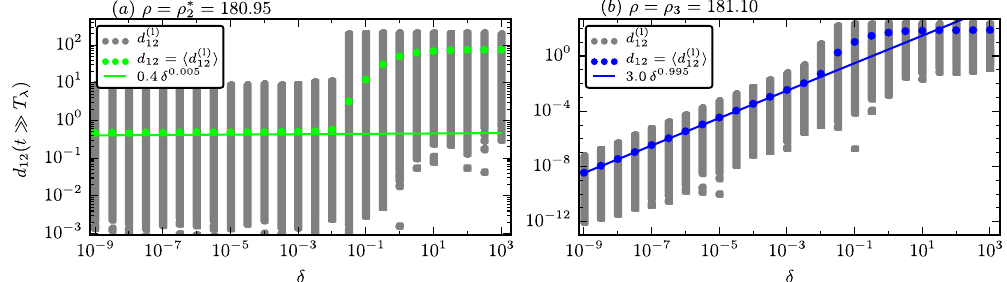
Figure 5. The scaling behavior of the averaged long-term distance d 12 ( t = 200) (colored circles), see Eq. (2), with the respective fits on a log-log scale (fitted for δ < 10 − 2 ) (solid lines, cf. Fig. 3). The distribution of the non- averaged distances = d t ( 200) 12(l) , as obtained from 1000 initial conditions, are shown in addition (gray circles). ( a ) For PPC with ρ ρ = = . ⁎ 180 95 one finds, in agreement with Fig. 3, a close to constant cross-distance 2 scaling. ( b ) For a laminar flow with ρ = ρ 3 = 181.10 the scaling exponent is ν ≈ 1 for distances δ < 10 − 2 . In both cases the scaling breaks down when a symmetry related close-by attractor starts to attract a fraction of the orbits for δ > 10 − 2